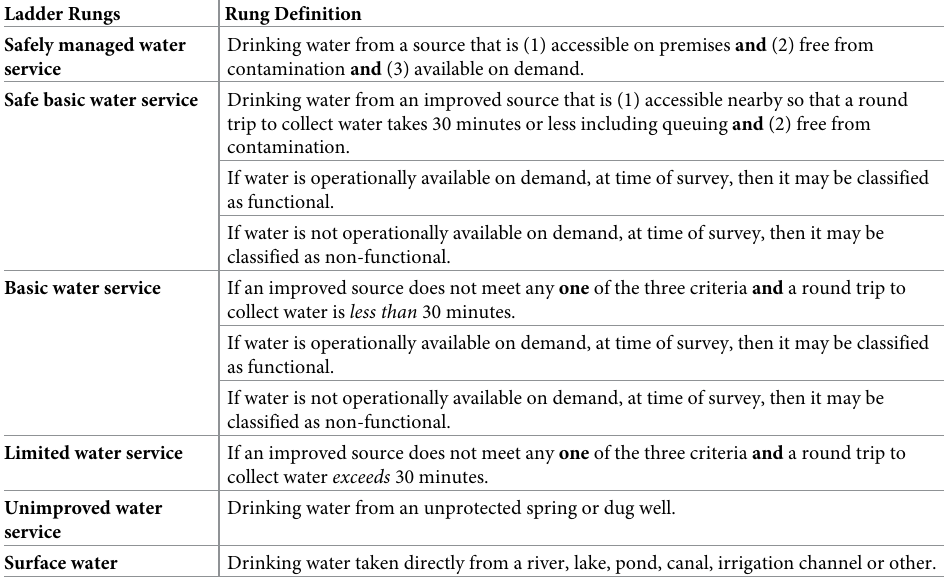
Table 12. Suggested revisions to drinking water ladder rungs: Adding “Safe Basic Water Service”.